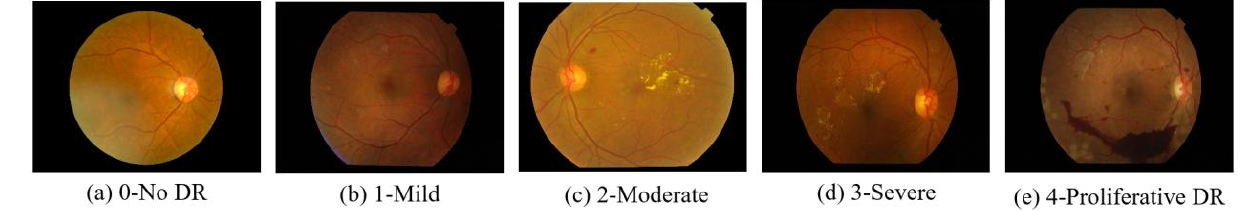
Figure 2. Image samples based on different severity.